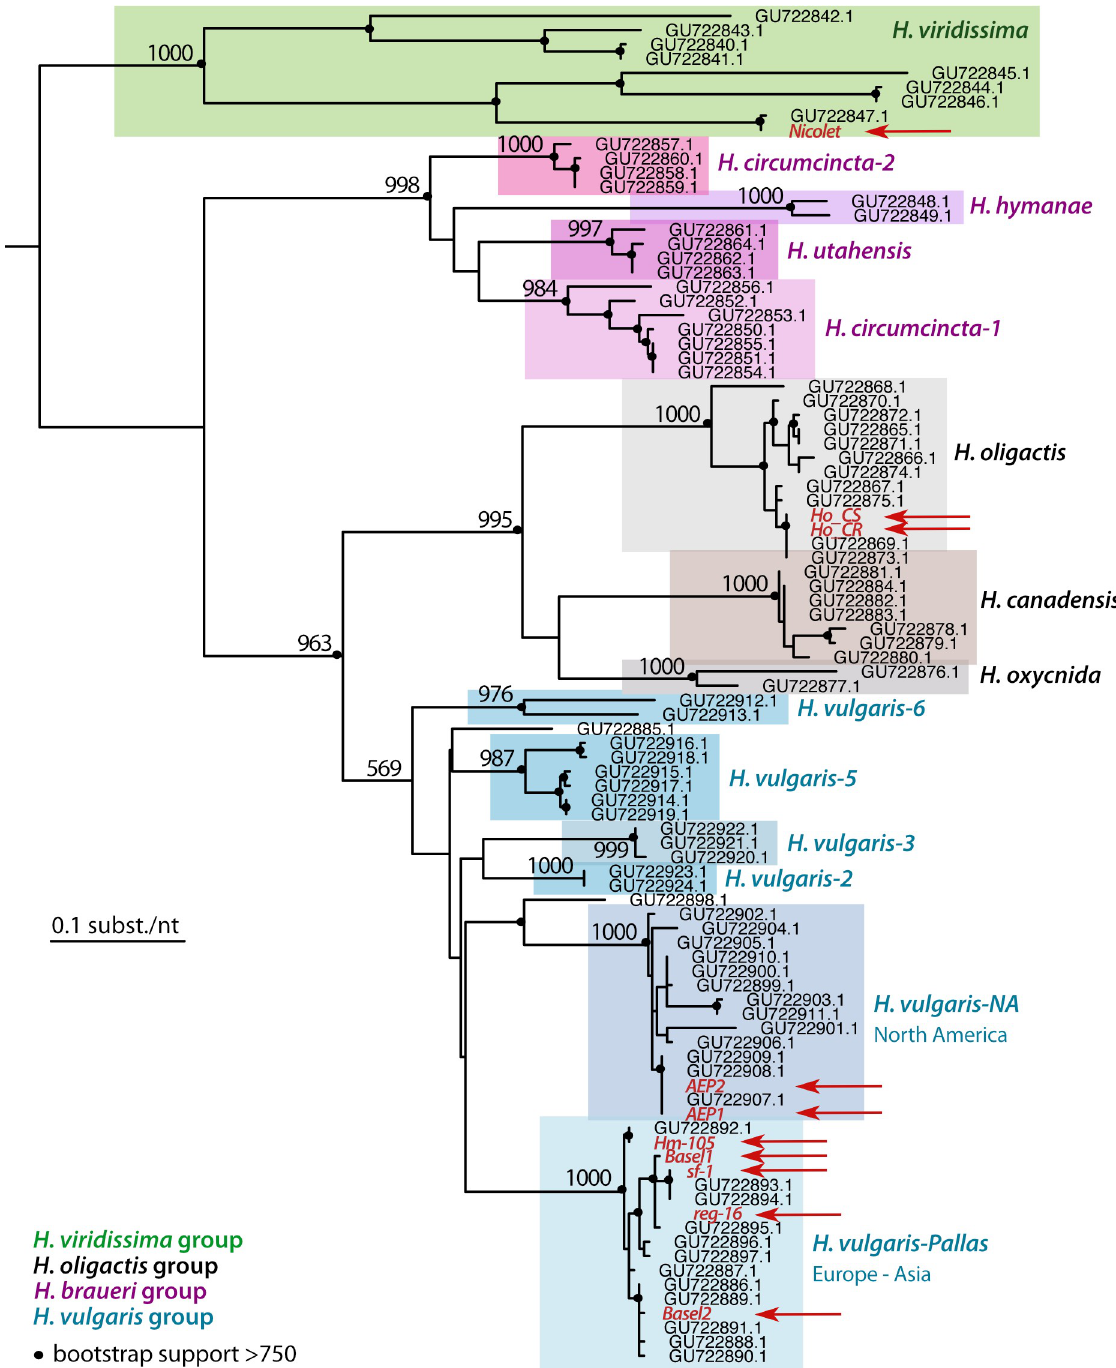
Fig 3. Phylogenetic relationships within the Hydra genus based on the analysis of the Cytochrome Oxydase I (COI) DNA sequences. The maximum likelihood tree of the COI sequences was built by adding to the dataset of 85 COI sequences available on Genbank [15] the 10 sequences obtained in the present study (written red, indicated with red arrows, see S2 Table for accession numbers). Black dots indicate the robustness of the nodes as deduced from the bootstrap support (at least 750 over 1’000 bootstraps). This tree confirms that the sequences obtained in this study distribute into the expected Hydra groups, Nicolet strain in H . viridissima , Ho_CR and Ho_CS in H . oligactis , Hm-105 , sf-1 , reg-16 , Basel-1 and Basel-2 in H . vulgaris-Pallas , AEP1 , AEP2 in the H . vulgaris-NA sub-group.